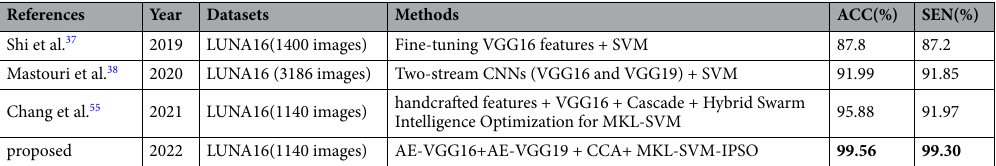
Table 10. Recognition performance of different classifiers. Significant values are in